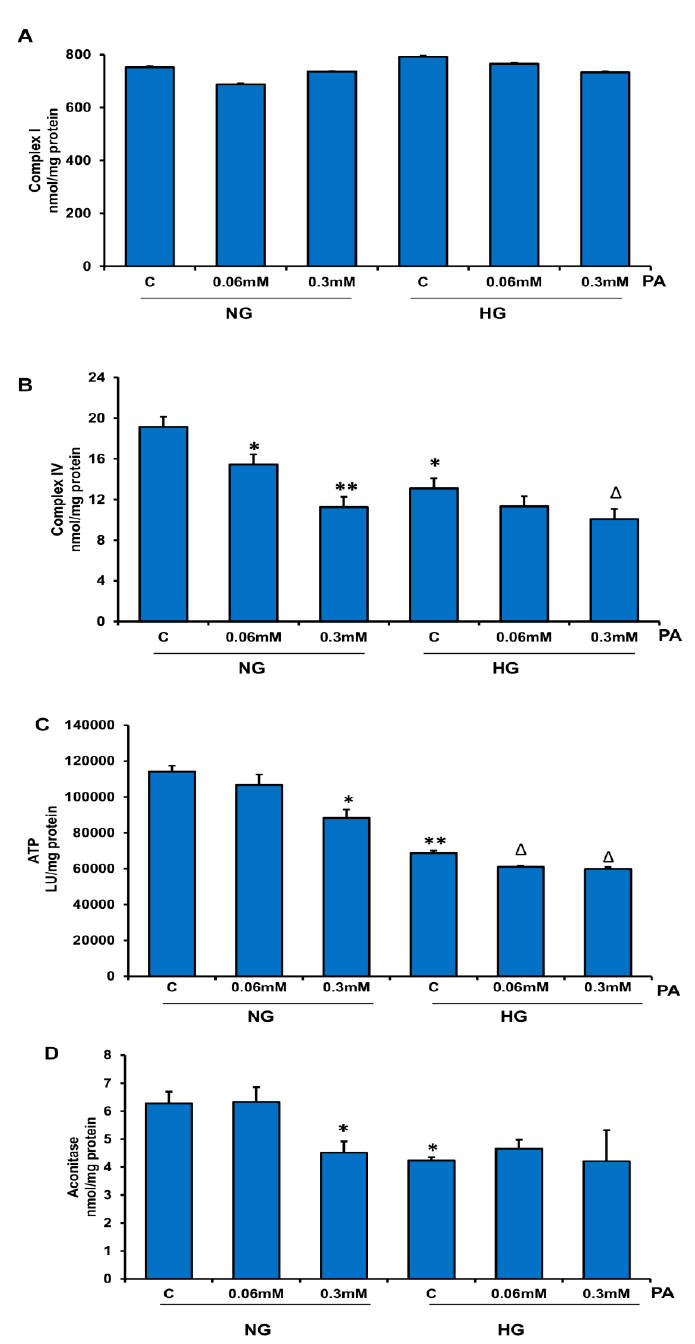
Figure 9. Effect of high glucose/high palmitic acid (HG/HPA) on mitochondrial enzymes and bioenergetics. HepG2 cells were treated with different doses of palmitic acid in the presence of normal and high glucose. Mitochondrial enzyme complexes, Complex I ( A ) and Complex IV ( B ), as well as ATP levels ( C ) and a ROS-sensitive enzyme, aconitase ( D ), were measured as described in the Materials and Methods section. Results are expressed as mean +/ − SEM of three experiments. Asterisks indicate significant differences (* p ≤ 0.05, ** p ≤ 0.005, *** p ≤ 0.001) relative to untreated control cells under normal glucose condition (NG-C), and triangles indicate significant differences ( Δ p ≤ 0.05, ΔΔ p ≤ 0.005) relative to untreated control cells under high glucose condition (HG-C).